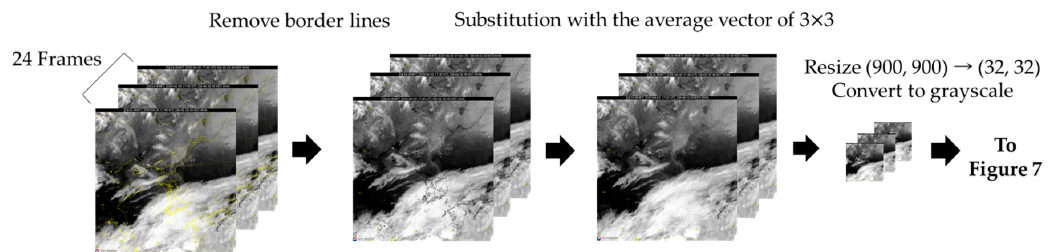
Figure 2. Process of removing border lines.